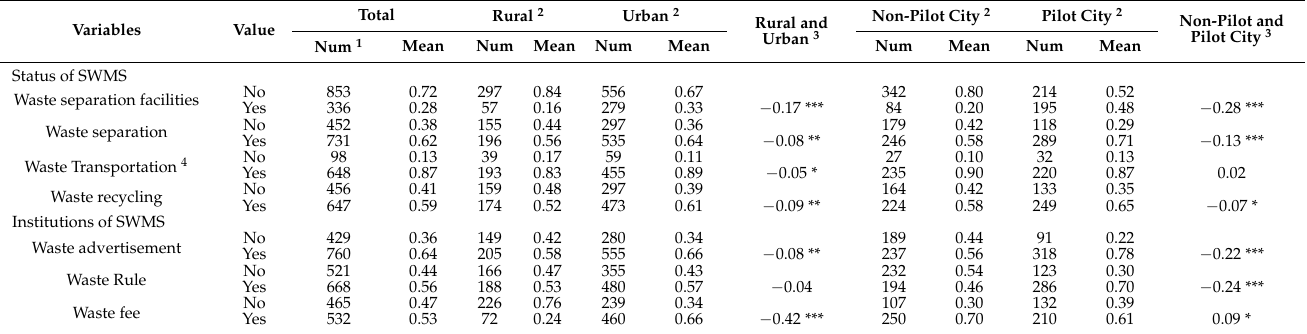
Table 2. Solid waste management services and institutions across regions and cities in